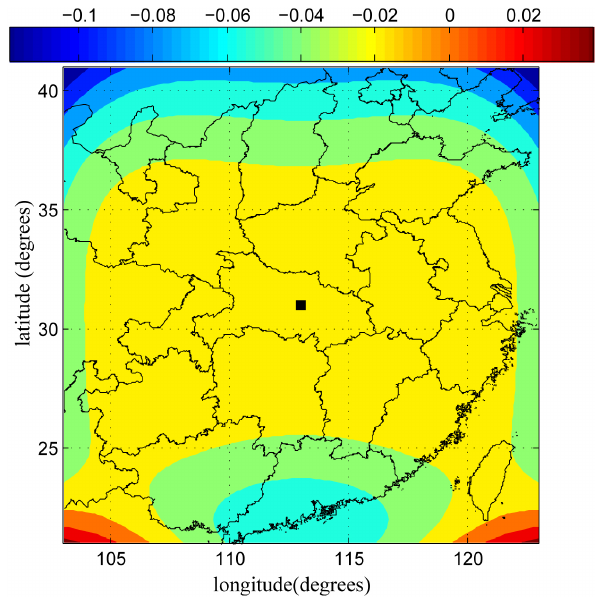
Fig. 4. The spatial distribution of the geodesic distance calculating difference between Eqs. (6) and (36) (in meter). The square is the beginning of each geodesic line. The difference is below in a large (yellow)